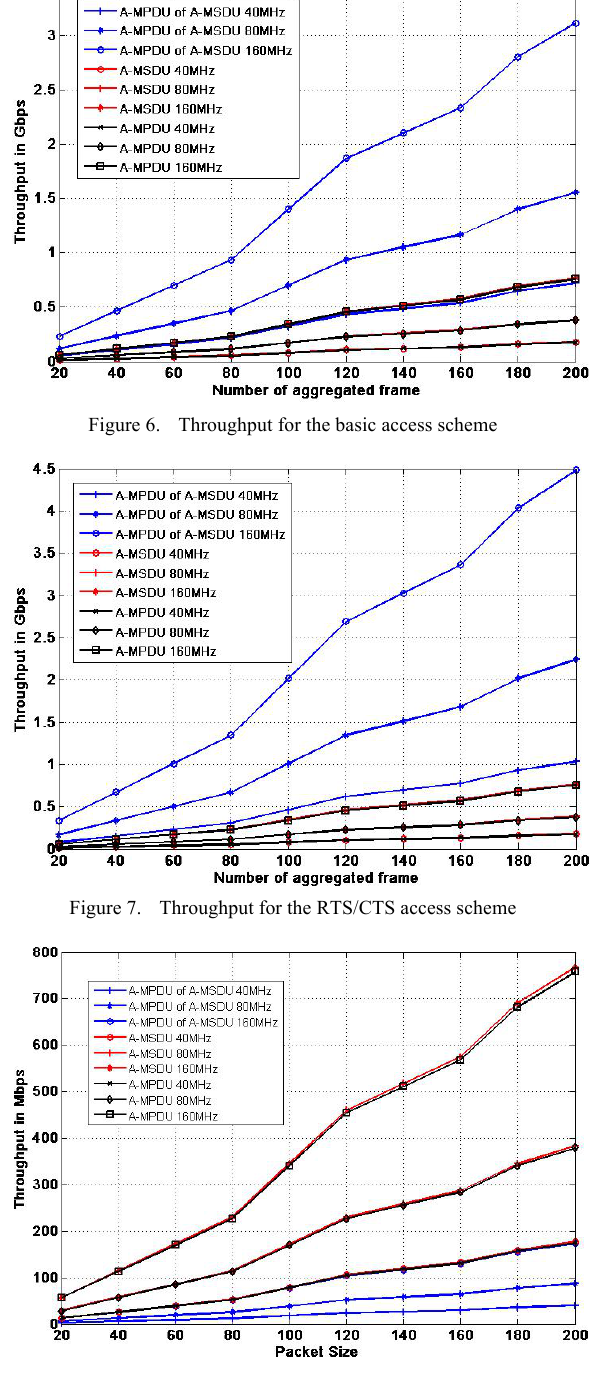
Figure 8. Throughput against the packet